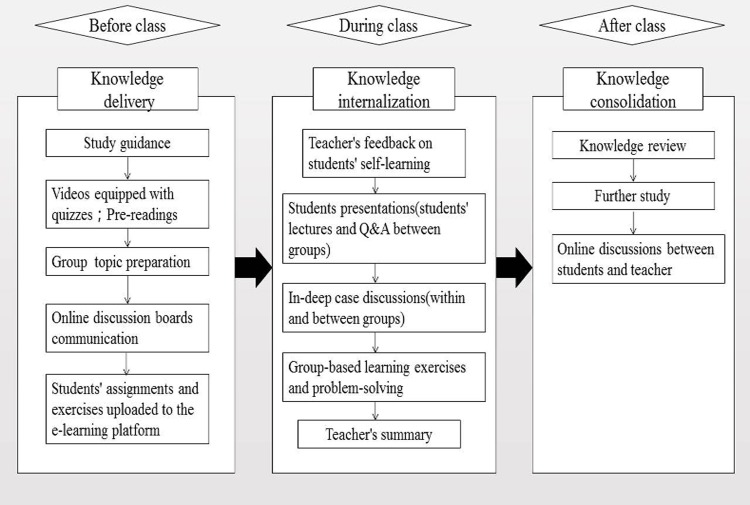
The flipped classroom structure and setting flowchart.